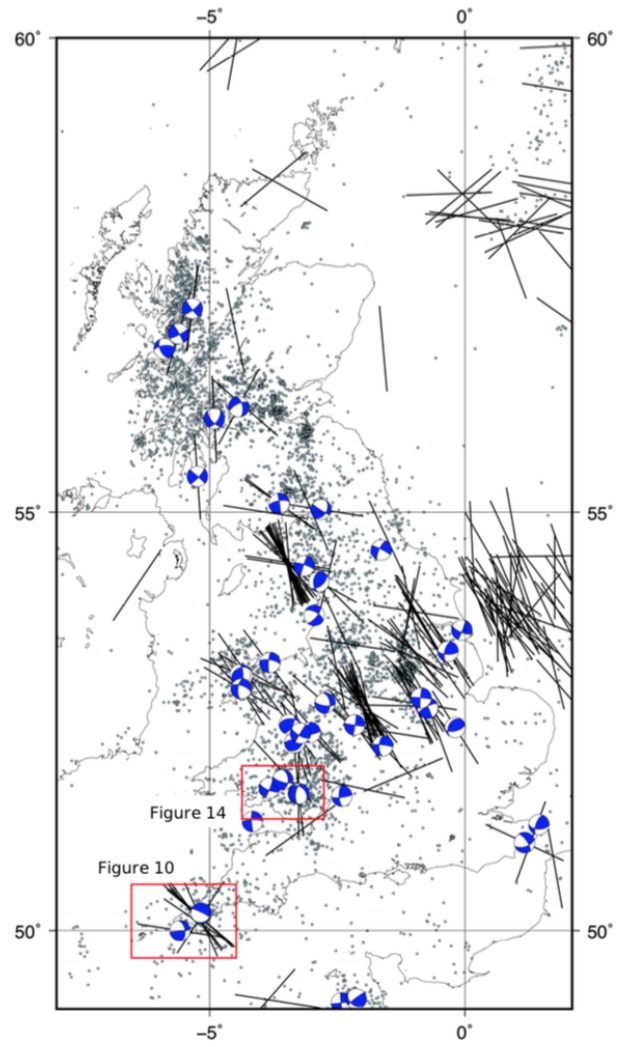
Figure 9. Map of most of the UK showing the locations of the se- lected case studies (red rectangles). Also shown are epicentres of seismicity (dots; British Geological Survey (BGS) catalogue; Mus- son, 1996), focal mechanisms (blue and white; Baptie, 2010), and orientations of the maximum horizontal stress (black lines; World Stress Map data; Heidbach et al.,